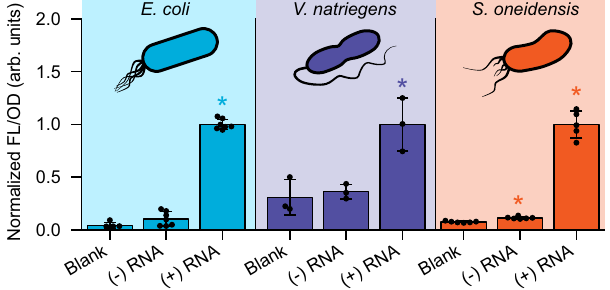
Fig. 5 | RENDR is portable across different Gram-negative bacteria. Character- ization of RENDR across three different Gram-negative bacteria. Fluorescence characterization (measured in units of fl uorescence [FL]/optical density [OD] at 600nm)wasperformed in E.coli , V.natriegens , and S . oneidensis transformed with the RENDR plasmid in the presence (+) and absence ( − ) of RNA input. Auto- fl uorescencewasdeterminedusingcellstransformedwithemptyplasmids(blank). Barsshownormalized meanvalues and error bars represent s.d.of n =7, n =3, and n =6biologicalreplicatesshownaspointsfor E.coli , V.natriegens ,and S.oneidensis , respectively.FortheBlank E.coli conditionandthe(+) S.oneidensis condition, n =5, Signi fi cance was determined using a two-tailed t-test (alpha=0.05), which resulted in p -valuesof2.2e − 12,0.013,and3.4e − 8for(+)RNAsamplesin E.coli , V.natriegens , and S. oneidensis relative to ( − ) RNA, respectively. Statistically signi fi cant differ- ences( p <0.05)areindicatedbyasterisksabovebars.Sourcedataareprovidedasa Source Data fi